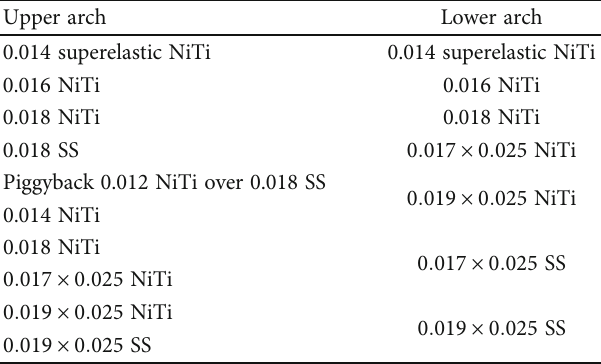
Table 1: The arch sequence for both